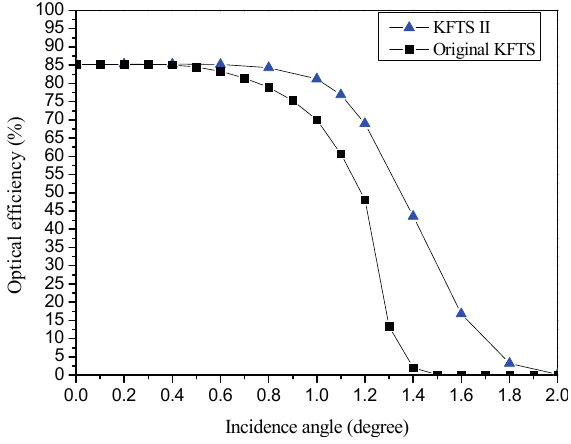
Figure 16. Optical efficiency of the Fresnel lens with KFTS SOE and KFTS II SOE.